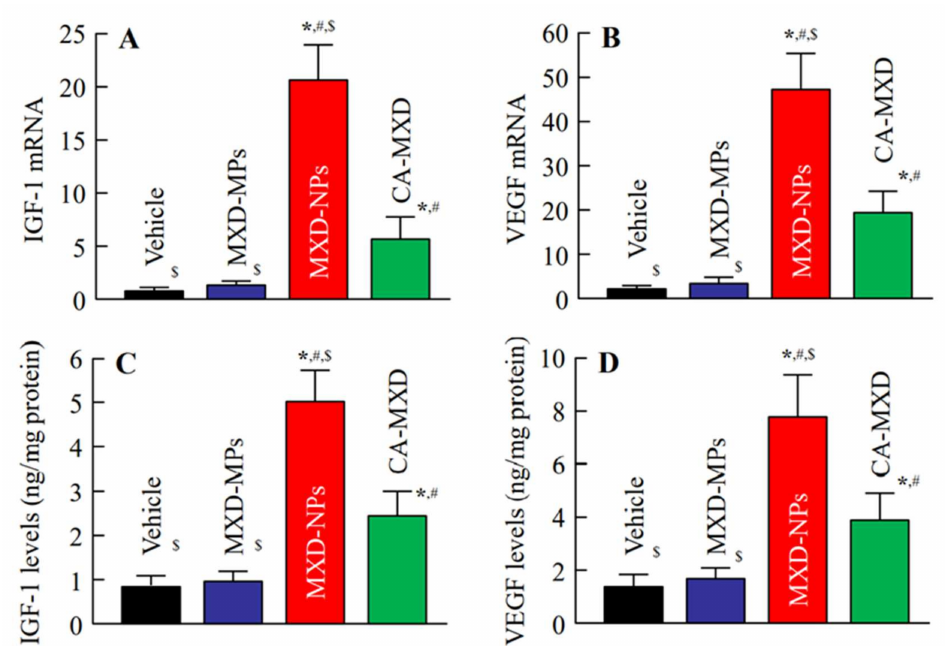
Figure 5. Effect of the MXD formulations (particle types and solution type) on IGF-1 and VEGF in the hair follicles of C57BL/6 mice at 8 d after the start of repetitive applications (once a day). ( A ) Expression of IGF-1 and ( B ) VEGF mRNA in C57BL/6 mice treated with MXD formulations. ( C ) IGF-1 and ( D ) VEGF levels in C57BL/6 mice treated with MXD formulations. The samples were prepared from the hair follicle (hair bulge and hair bulb region). Vehicle, only the vehicle used to prepare the MXD-MPs and MXD-NPs formulations was applied. MXD-MPs, MXD-MPs-applied mice. MXD-NPs, MXD-NPs-applied mice. CA-MXD, CA-MXD-applied mice. n = 5–9. * p < 0.05 vs. Vehicle for each category. # p < 0.05 vs. MXD-MPs for each group. $ p < 0.05 vs. CA-MXD for each group. The repeated treatment of MXD-NPs increased both the mRNA and protein levels of IGF-1 and VEGF, compared with those in the Vehicle, MXD-MPs and CA-MXD